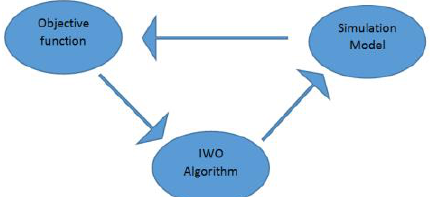
Figure 5. The circle of the simulation Hierarchy - Optimization